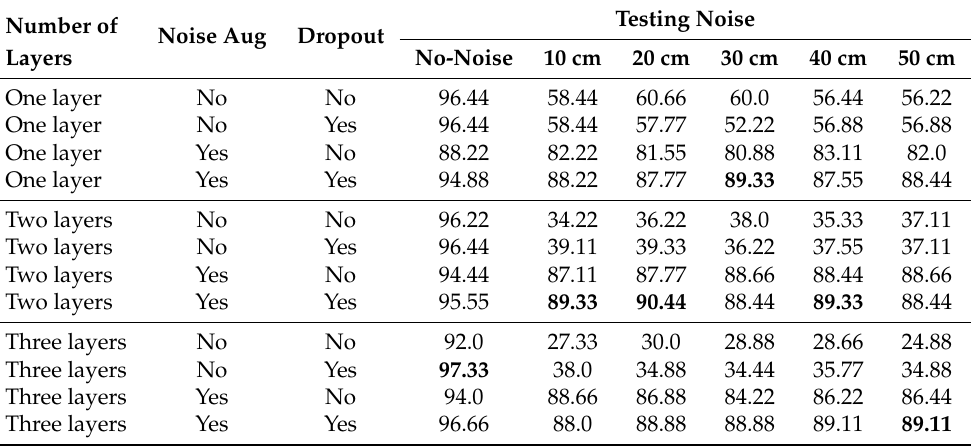
Table 7. Varying architecture results. Each row represents a trained model with either one, two or three layer; as well as with and without noise augmentation and recurrent dropout. The best result on each column is highlighted in